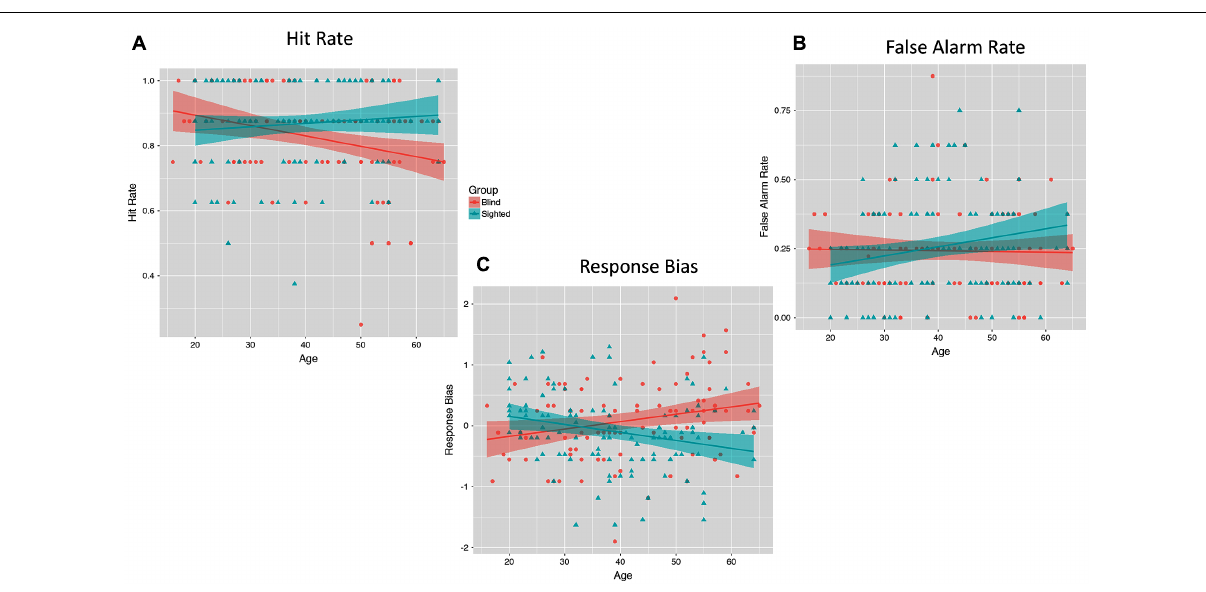
unrelated to age among blind individuals ( B = − 0.04, SE = 0.11, p = 0.69). Response bias increased with age among blind individuals ( B = 0.018, SE = 0.01, p = 0.025), while it decreased with age among sighted individuals ( B = − 0.02, SE = 0.01, p =